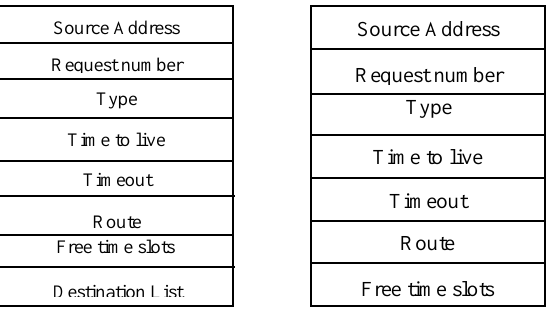
Figure 2. Structures of RREQ and